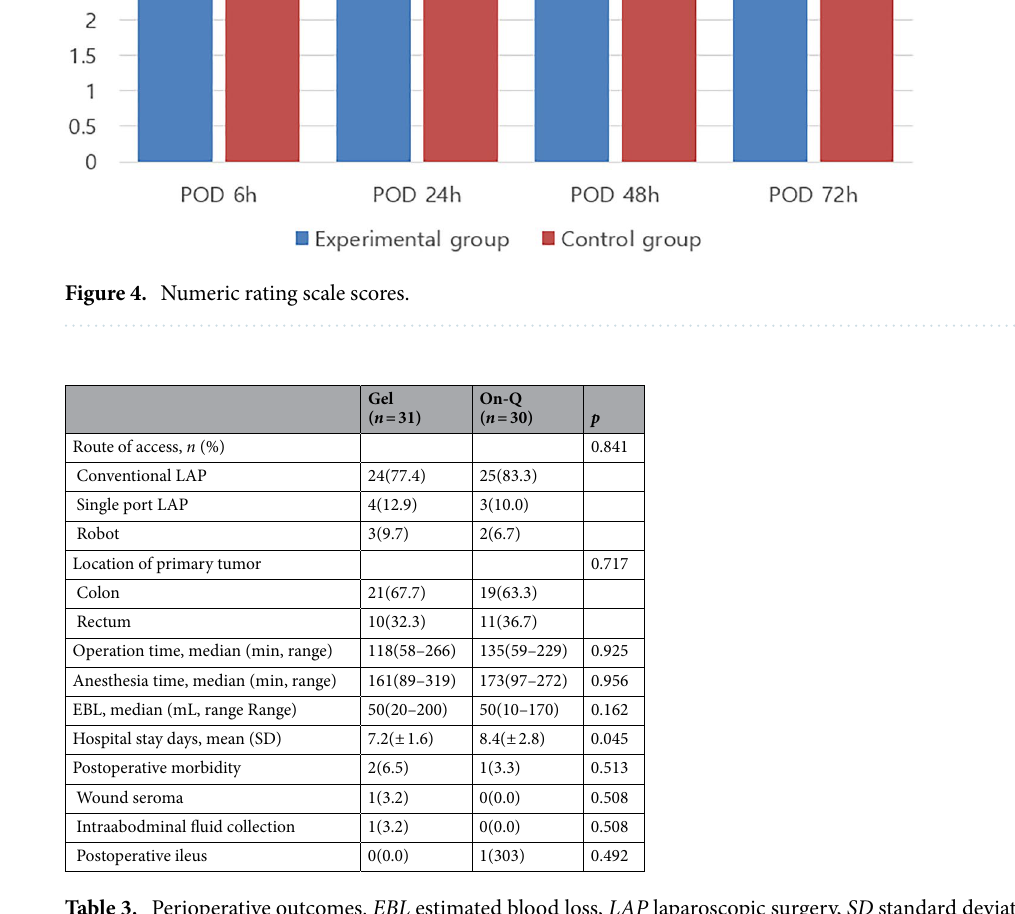
Table 3. Perioperative outcomes. EBL estimated blood loss, LAP laparoscopic surgery, SD standard